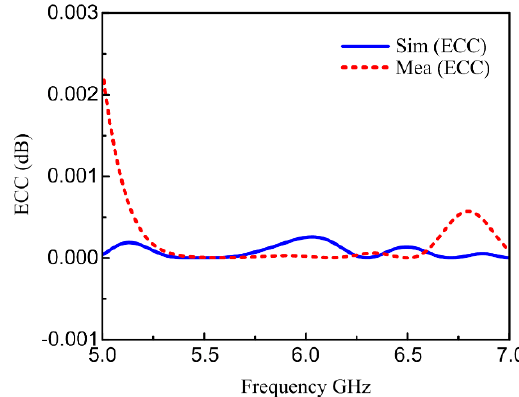
Figure 12. Proposed measured and simulated ECC.